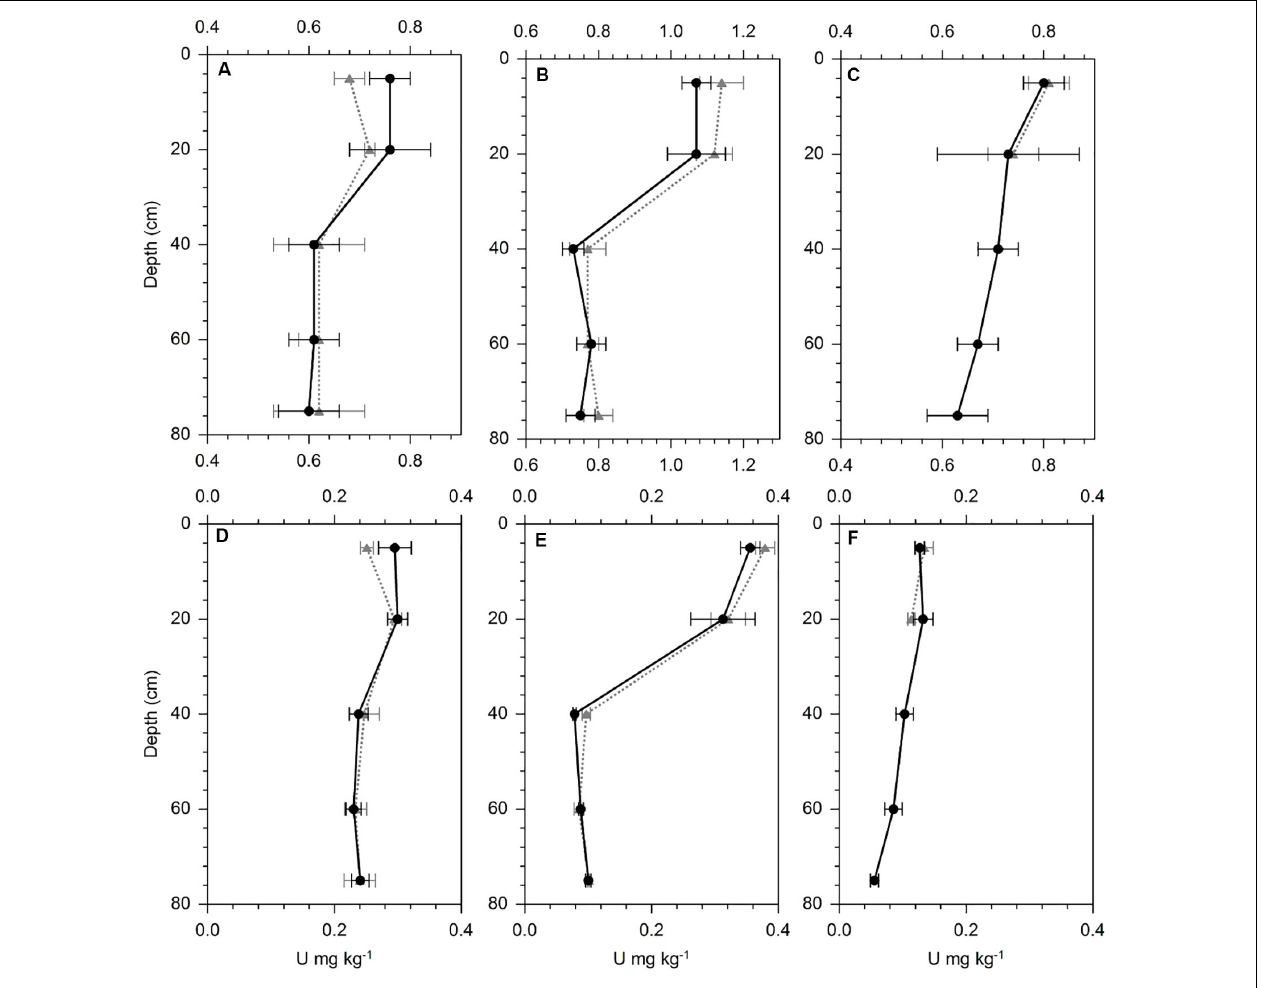
FIGURE 5 | U concentration in HNO 3 digests (A–C) and NaHCO 3 (D–F) extracts from the three preferential flow path soil profiles (dotted gray line) and the matrix soil samples (straight black line) at (A,D) Landquart, (B,E) Oensingen, and (C,F) Wiedlisbach. Error bars represent the standard deviation of five replicate samples per sampling